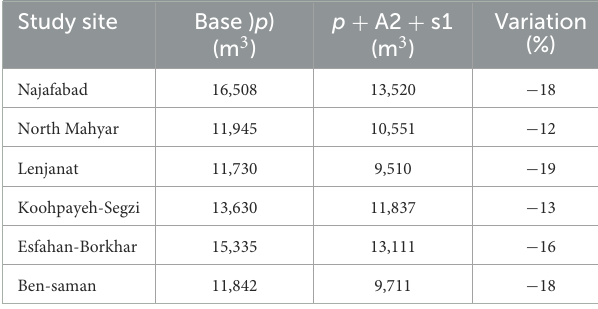
TABLE 4 The result of available water